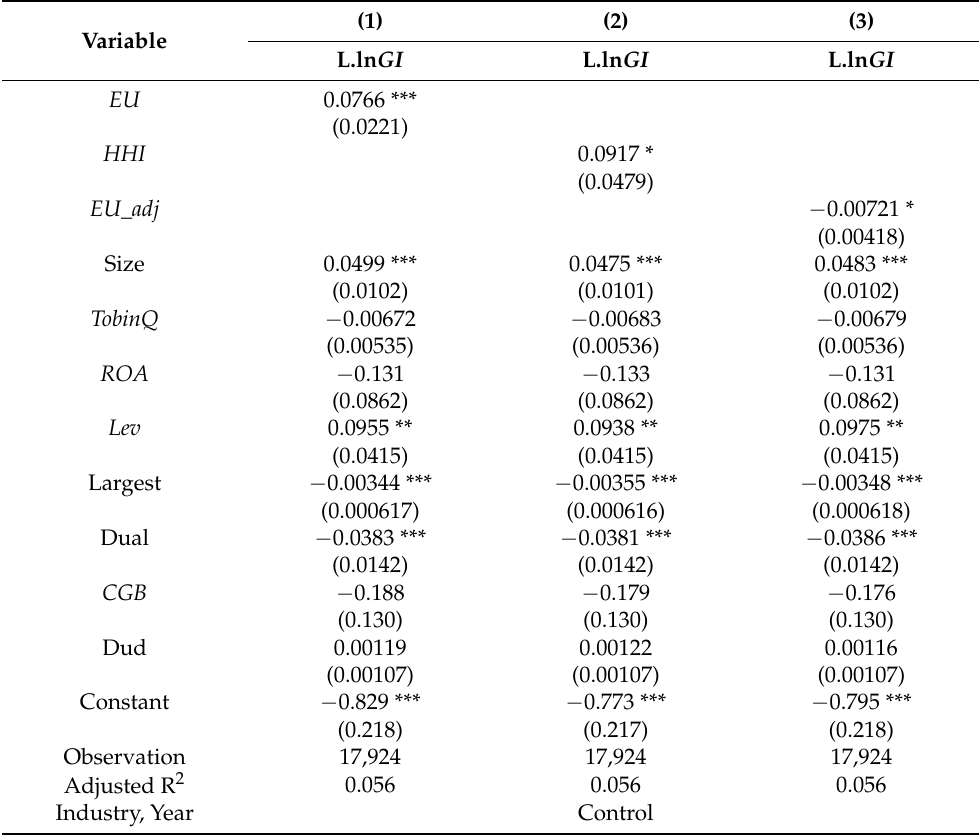
Table 11. Regression Analysis of Environmental Uncertainty and Enterprises’ Green Technological Innovation Lagging One